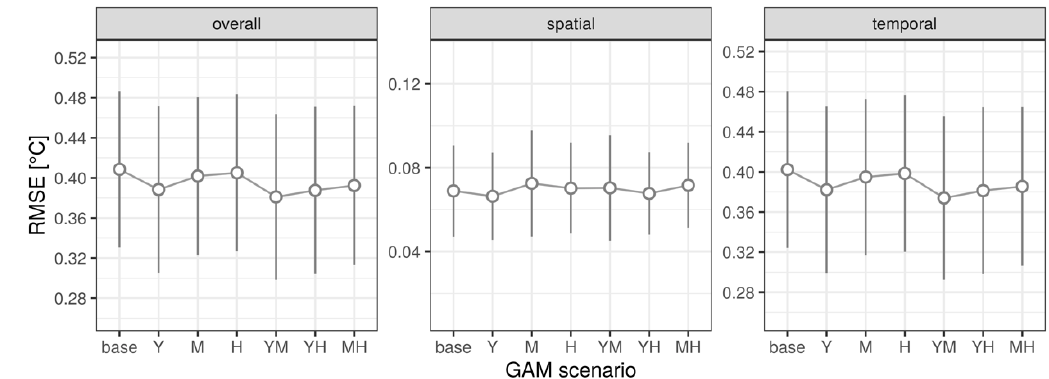
Figure 19. Mean (circle) and standard deviation (error bar) of RMSE ( overall , spatial and temporal ) averaged over GAM performance of all weather stations at different data partition scenarios. The difference among scenarios is negligible.